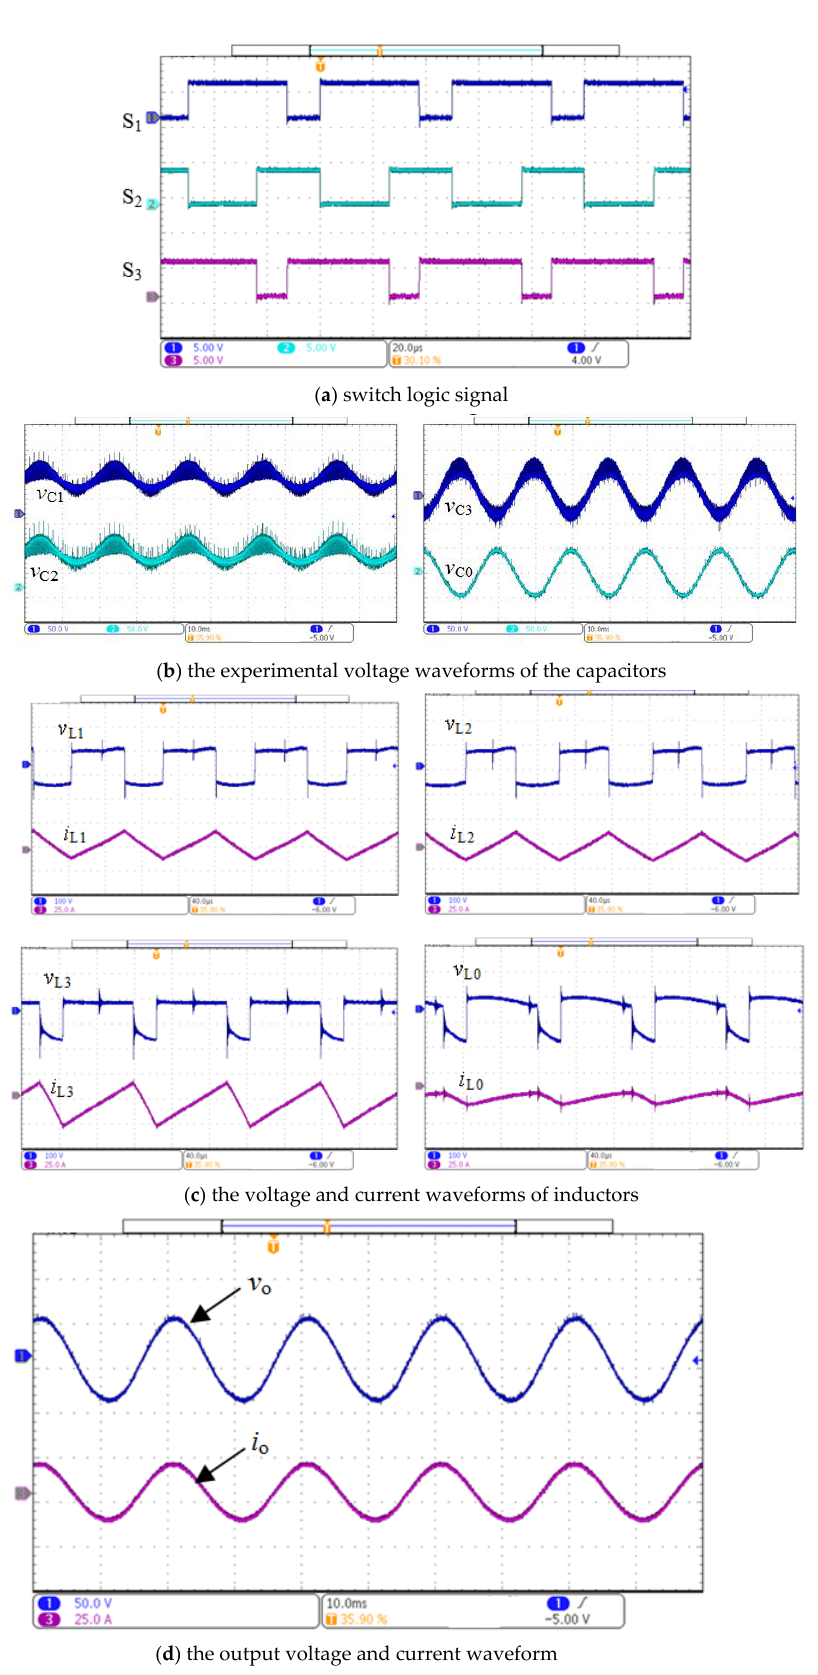
Figure 5. Experimental results.